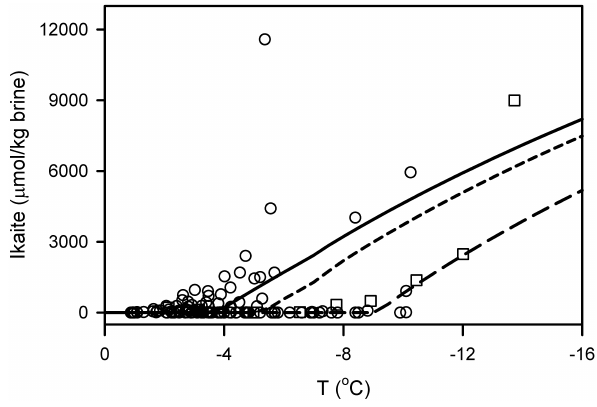
Figure 3. Abundance of ikaite in sea ice, expressed as ikaite concen- tration in brine, as a function of temperature. Symbols are observed ikaite concentrations at SERF from this work (circles: measurement within 30 min of sample collection; squares: samples taken on Jan- uary 24 after the snow clearance). The lines show equilibrium ikaite concentrations modeled by FREZCHEM as 1kg of SERF seawa- ter ( S = 32.9, TA = 2380µmolkg − 1 ) freezes from 0 to − 16 ◦ C un- der different p CO 2 values: 390µatm (solid line), 1000µatm (short dashed line), and 5000µatm (long dashed